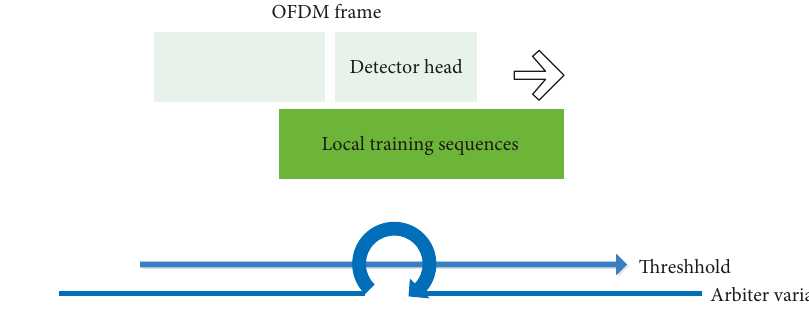
Figure 12: Local autocorrelation